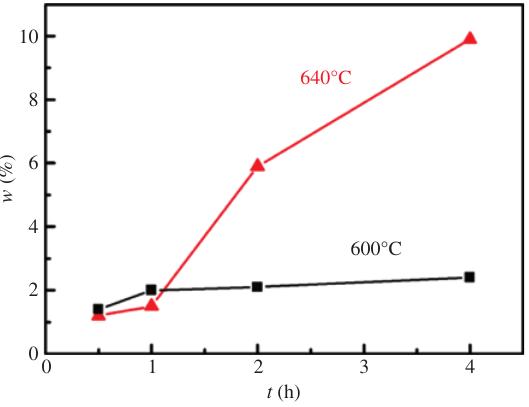
C in Gr /Al composites after heat 4 3 f